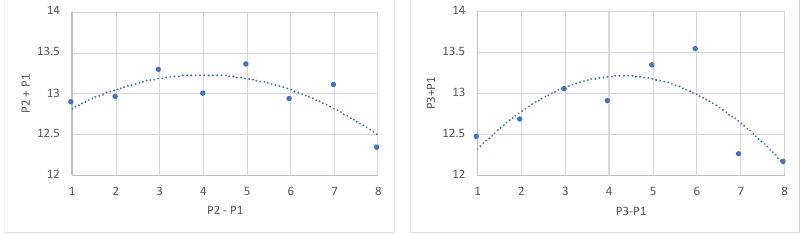
Figure 3. Relations between relative performance and the sum of the score for self and the score for his or her colleagues